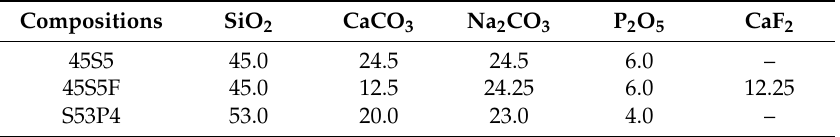
Table 1. Three different batches of bioactive glass for the experiments